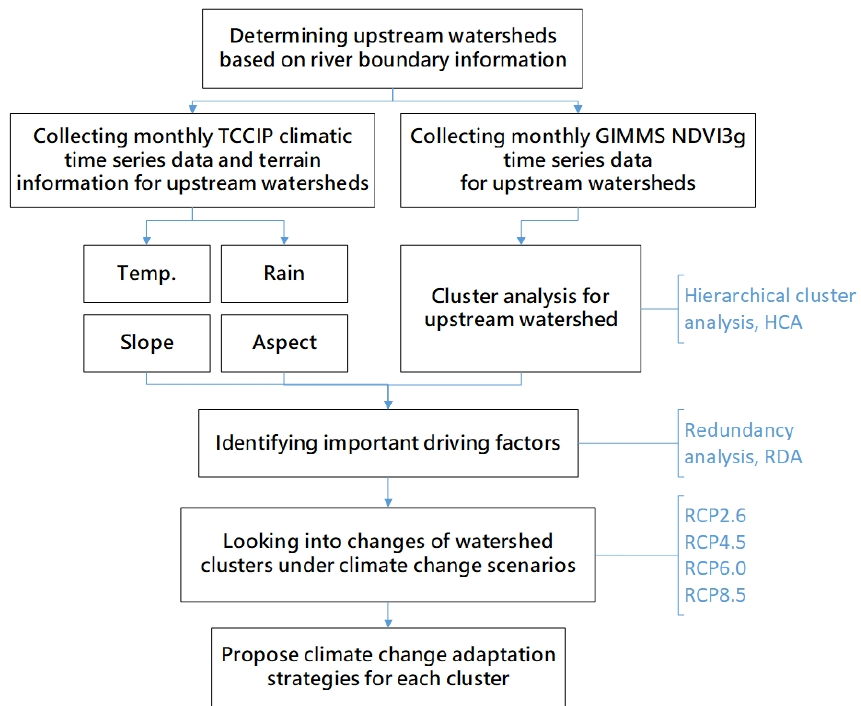
Figure 1. Research procedure of this study.